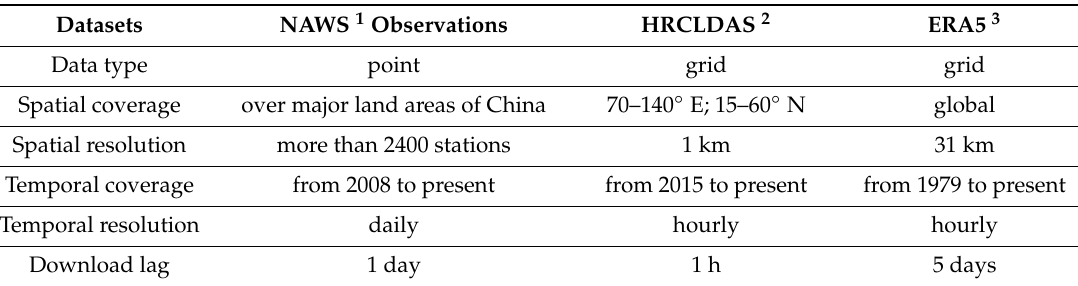
Table 1. Datasets